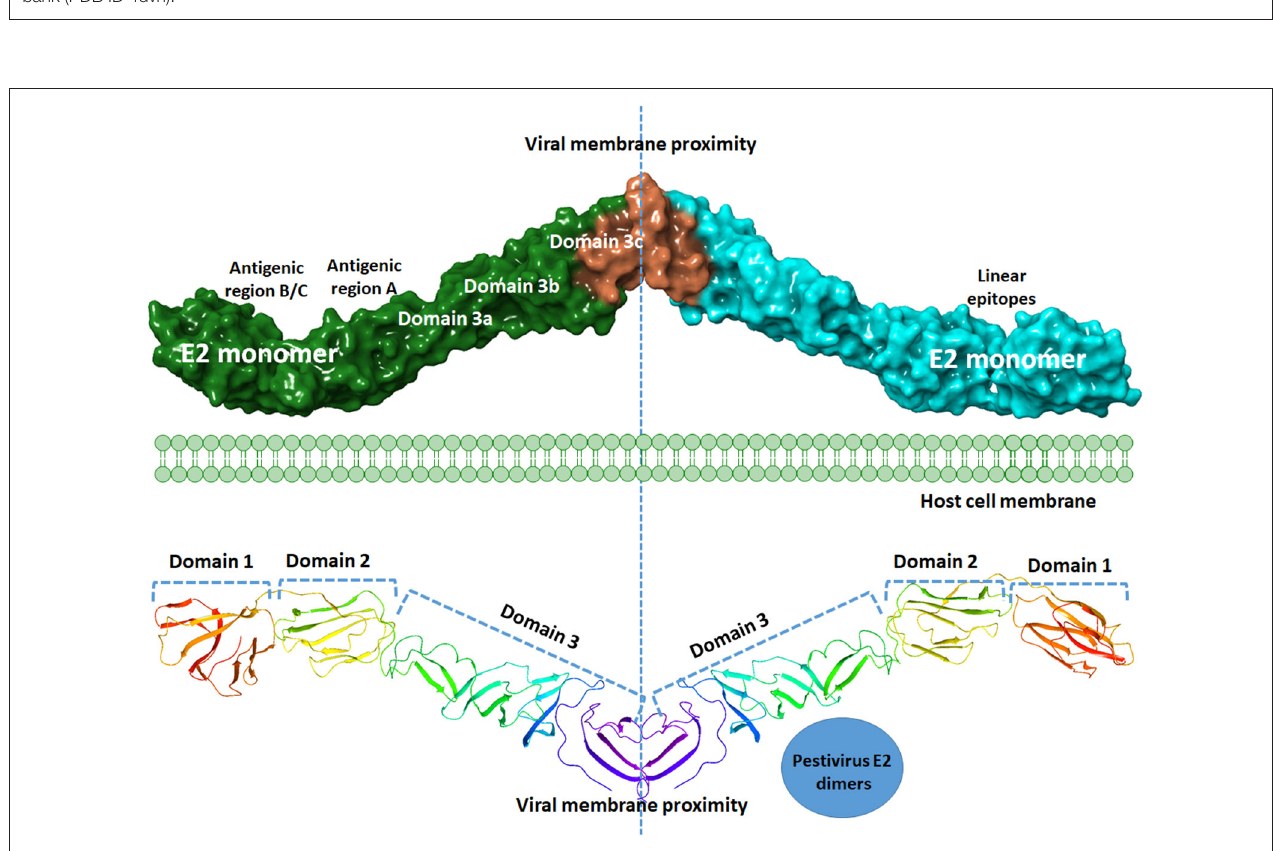
FIGURE 4 | Graphical representation of BVDV E2 dimers. A model of the graphical representation of the E2 dimers. Cartoon (upper panel) or surface representation (lower panel) are provided. The domain contents of each monomer, antigenic sites, and the subdomains are highlighted. Each E2 monomer contains three domains, domain 1, 2, and 3. Domains can be divided into subdomains 3a, 3b, and 3c. Three regions of linear epitopes comprising antigenic regions A, B, and C. E2 glycoprotein is thought to share in the membrane fusion process during virus entry, yet the exact mechanism is to be investigated. The figure was derived from the structure deposited in the protein data bank (PDB ID